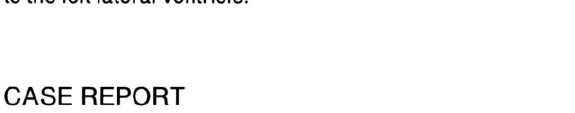
FIG. 1. MRI T.-weighted axial view showing a large high intensity area in the territory of the right middle cerebral artery and a smaller, subcortical lesion located posteriorly to the left lateral